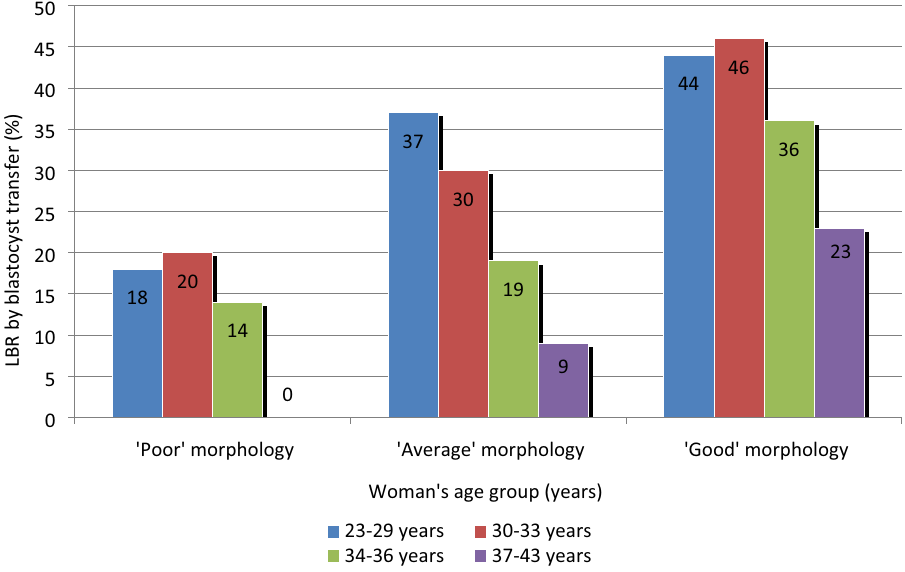
Figure 4. Live birth rate (LBR) by transfer according to D5 blastocyst morphology and the woman’s age group. LBR: live birth rate. Morphological assessment based on the expansion of the blastocoel cavity (B1–B6) and the number and cohesiveness of the inner cell mass (ICM) and trophectoderm (TE) cells 25 . For blastocysts graded as B3–B6, it is possible to assign independent scores to the ICM and TE. For the ICM, grade A indicated a tightly packed ICM with many cells; grade B, a loosely grouped ICM with many cells; and grade C, an ICM with very few cells. For the TE, grade A indicated a TE with many cells forming a cohesive epithelium; grade B, a TE with few cells forming a loose epithelium; and grade C, a TE with very few cells. ‘Poor’morphology: B3–B6, CC. ‘Average’ morphology: B3–B6, AC/CA/BC/CB). ‘Good’morphology (B3–B6,